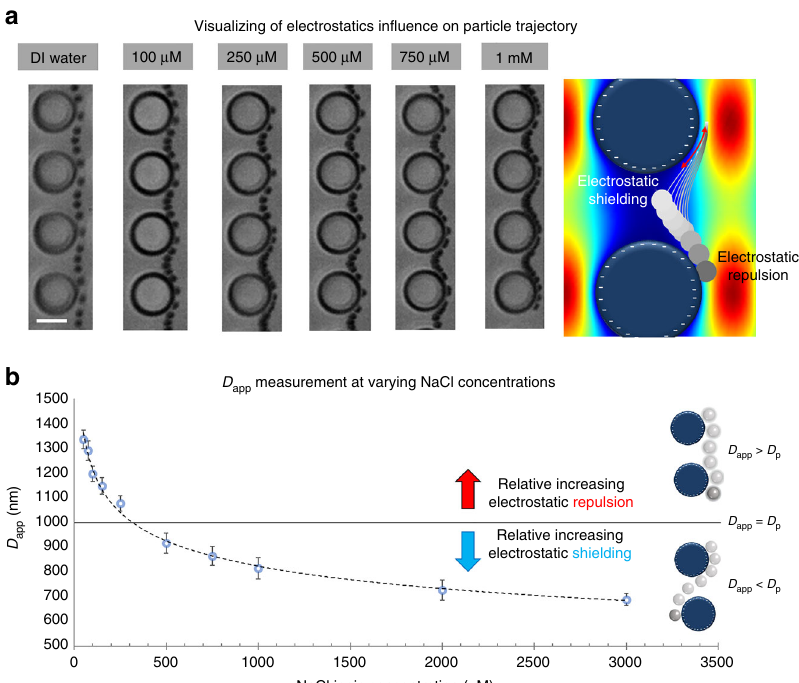
Fig. 2 Visualization of electrostatic dominant lateral shift phenomena. a Shows a tracked motion of 1 µ m PS beads within a DLD segment with predicted D µ m particle due to shifts in stream lines. Scale bar is 5 µ m. b NaCl buffer app to be > 700 nm and COMSOL computation of various trajectory taken by a 1 concentration modulates the electrostatic interactions and thus changes the D app . A decrease in ionic concentration results in a larger electrostatic repulsion and thus a positive increase in lateral shift where D app > D p . Conversely, the particle will appear smaller than D p due to increased electrostatic shielding for higher ionic concentrations. The error bars show the SD from at least 50 sample counts of beads